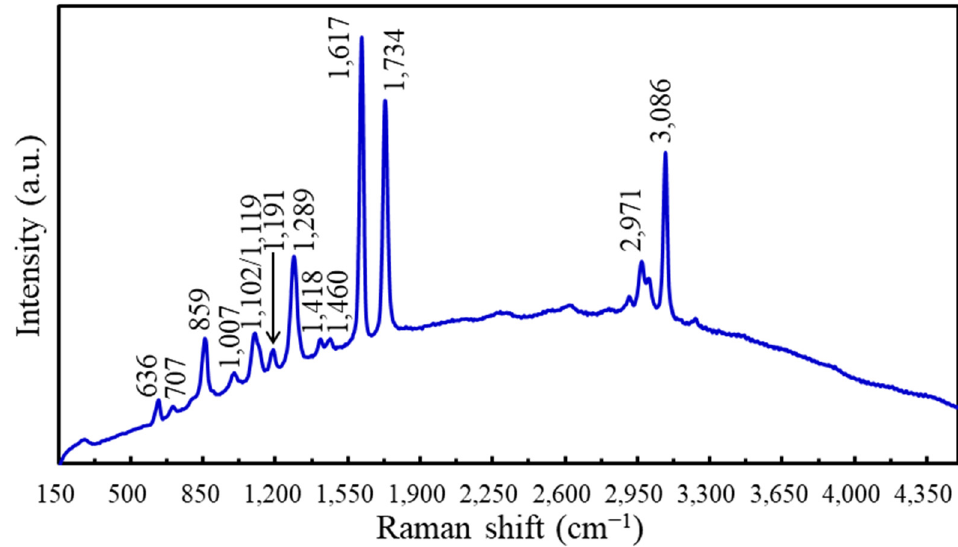
Figure 4. Raman spectra of the OMO sample, mainly showing the signal from the PET substrate. Table 1. Band assignment of the Raman spectrum for the PET substrate